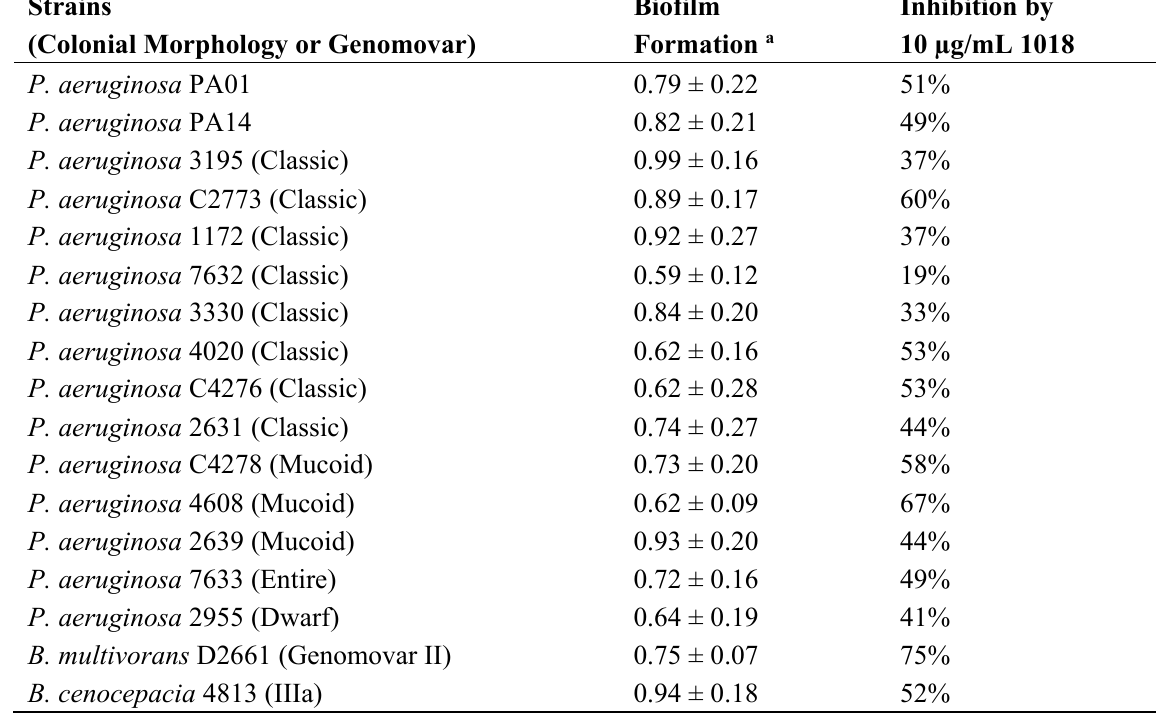
Table 2. Activity of peptide 1018 against biofilms formed by P. aeruginosa (PA) and Burkholderia (B) clinical isolates from cystic fibrosis (CF) patients. Usually three, but at least two independent experiments and eighteen replicates were performed per condition. The differentiating colony morphology or genomovar is given in brackets in the first column. Strains PAO1 and PA14 are reference strains that have been fully